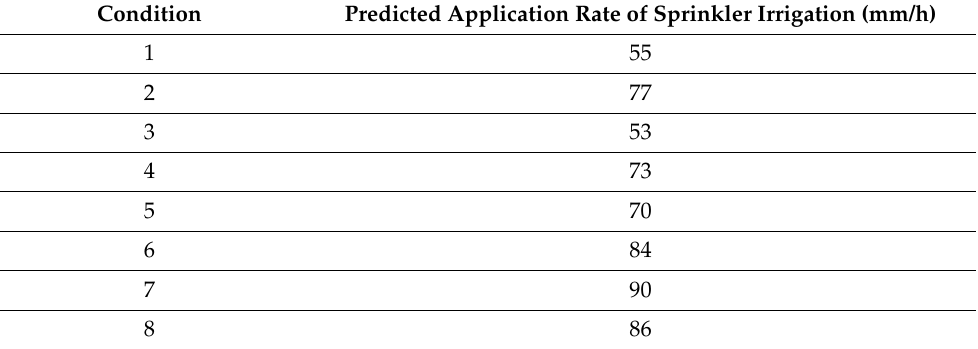
Table 7. Application rate of sprinkler irrigation predicted by RBF neural